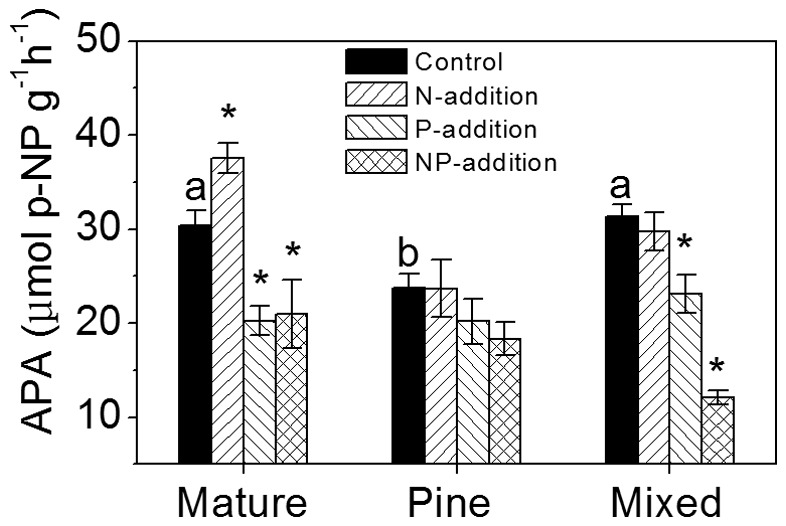
Acid phosphatase activity (APA) in bulk soil after four years of nitrogen and phosphorus additions.Data from July 2011. Different letters indicate significant differences among forests (P<0.05). * indicates significant differences between each treatments and control (P<0.05). Error bars show SE (n = 5).